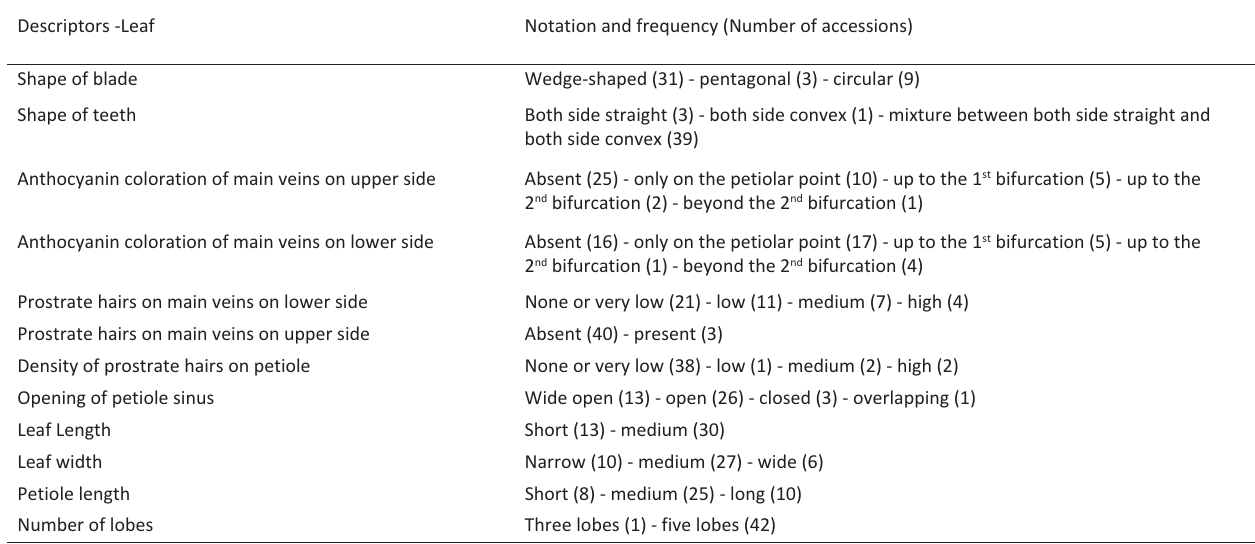
Table 4 ­ Leaf descriptors notation and their frequency distribution among the 43 studied